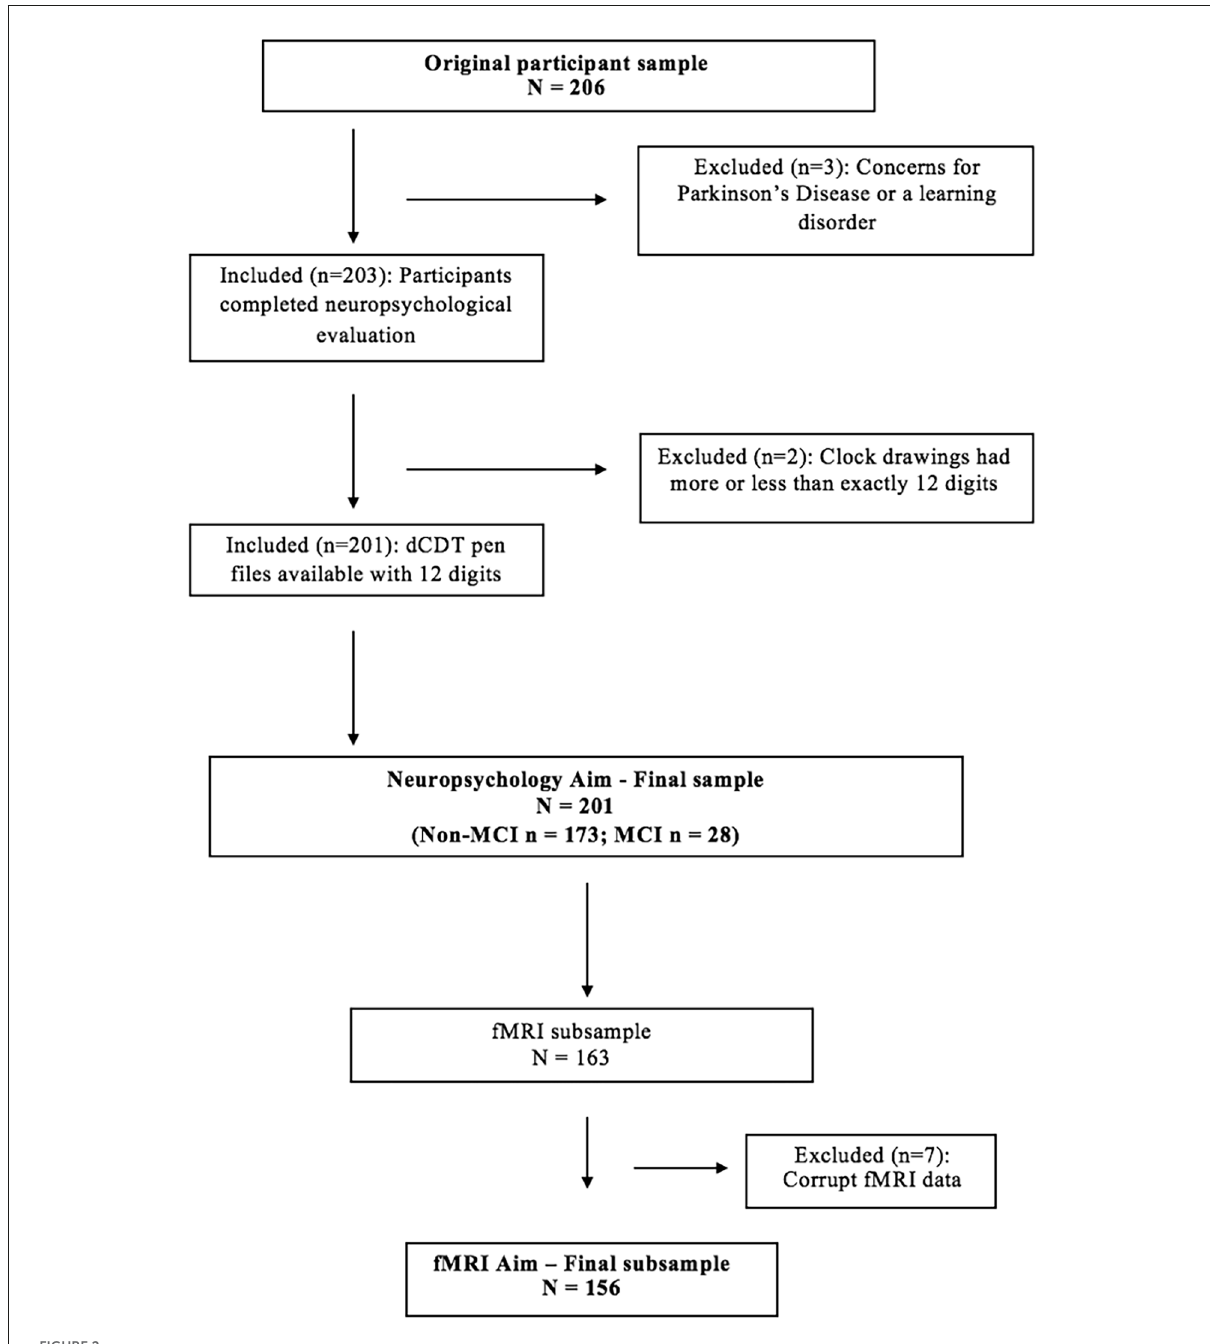
FIGURE2 Participant exclusion flow chart.